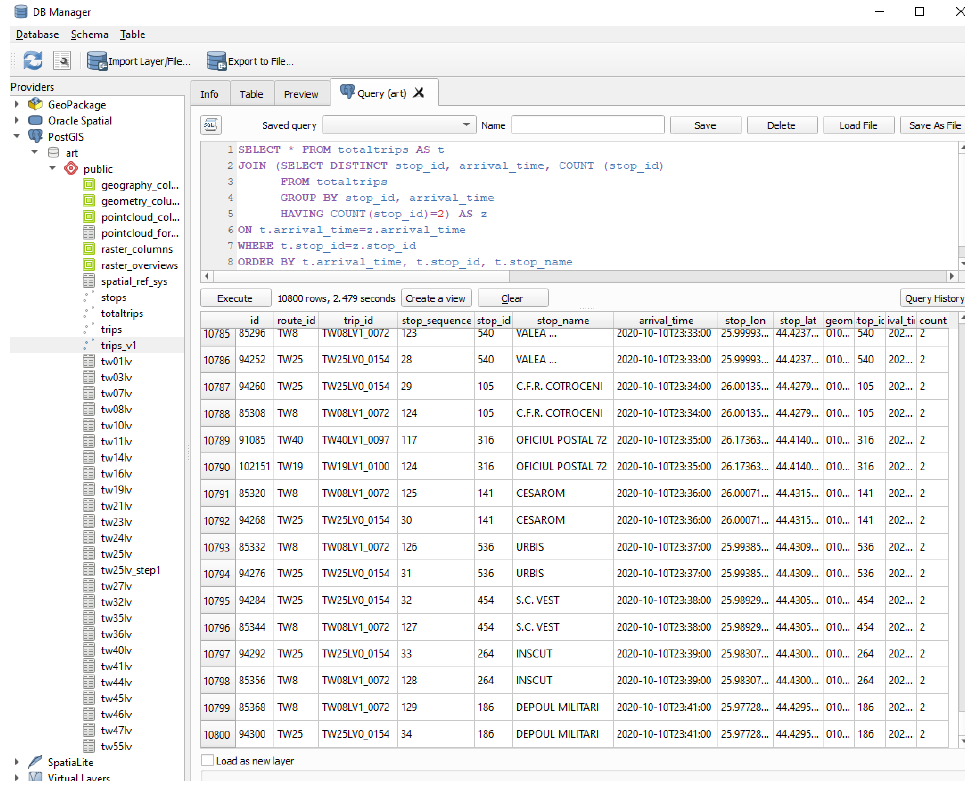
Figure 10. Number of cases of 2 trams arriving at the same station at the same time.